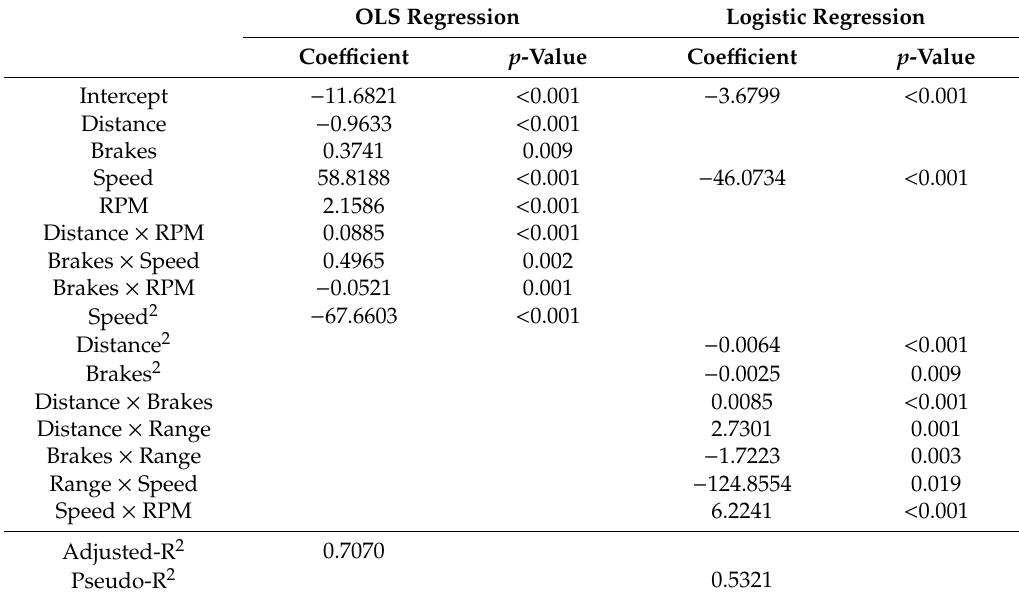
Table 4. Regression results with Accelerator as dependent